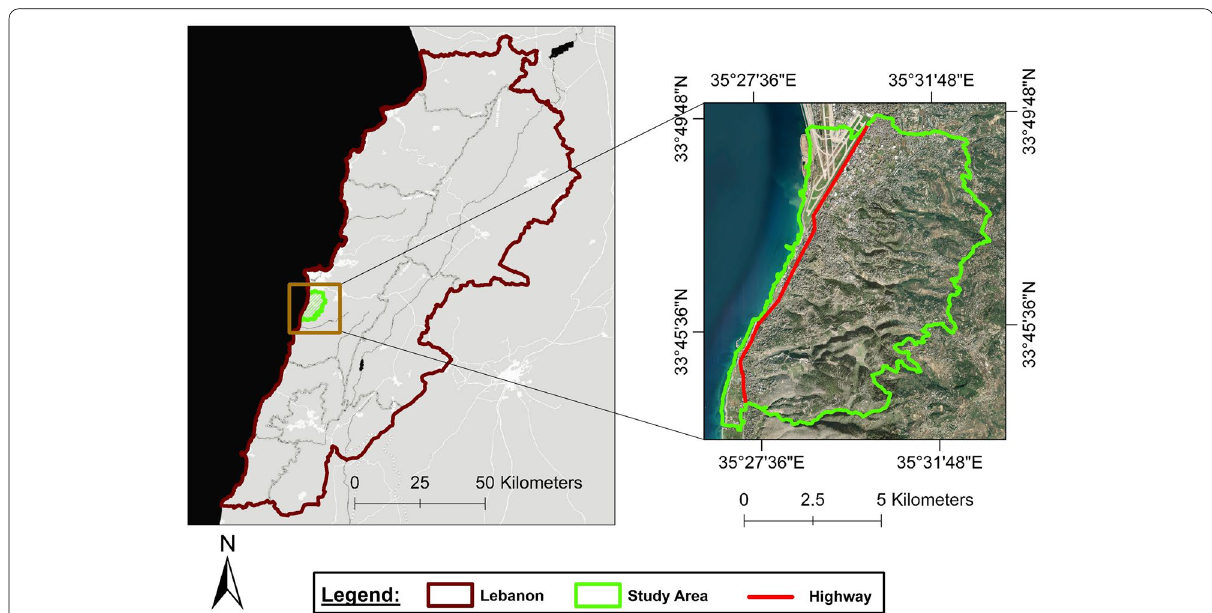
Fig. 1 The relative location of the study area corresponding to Lebanon in addition to its geometrical